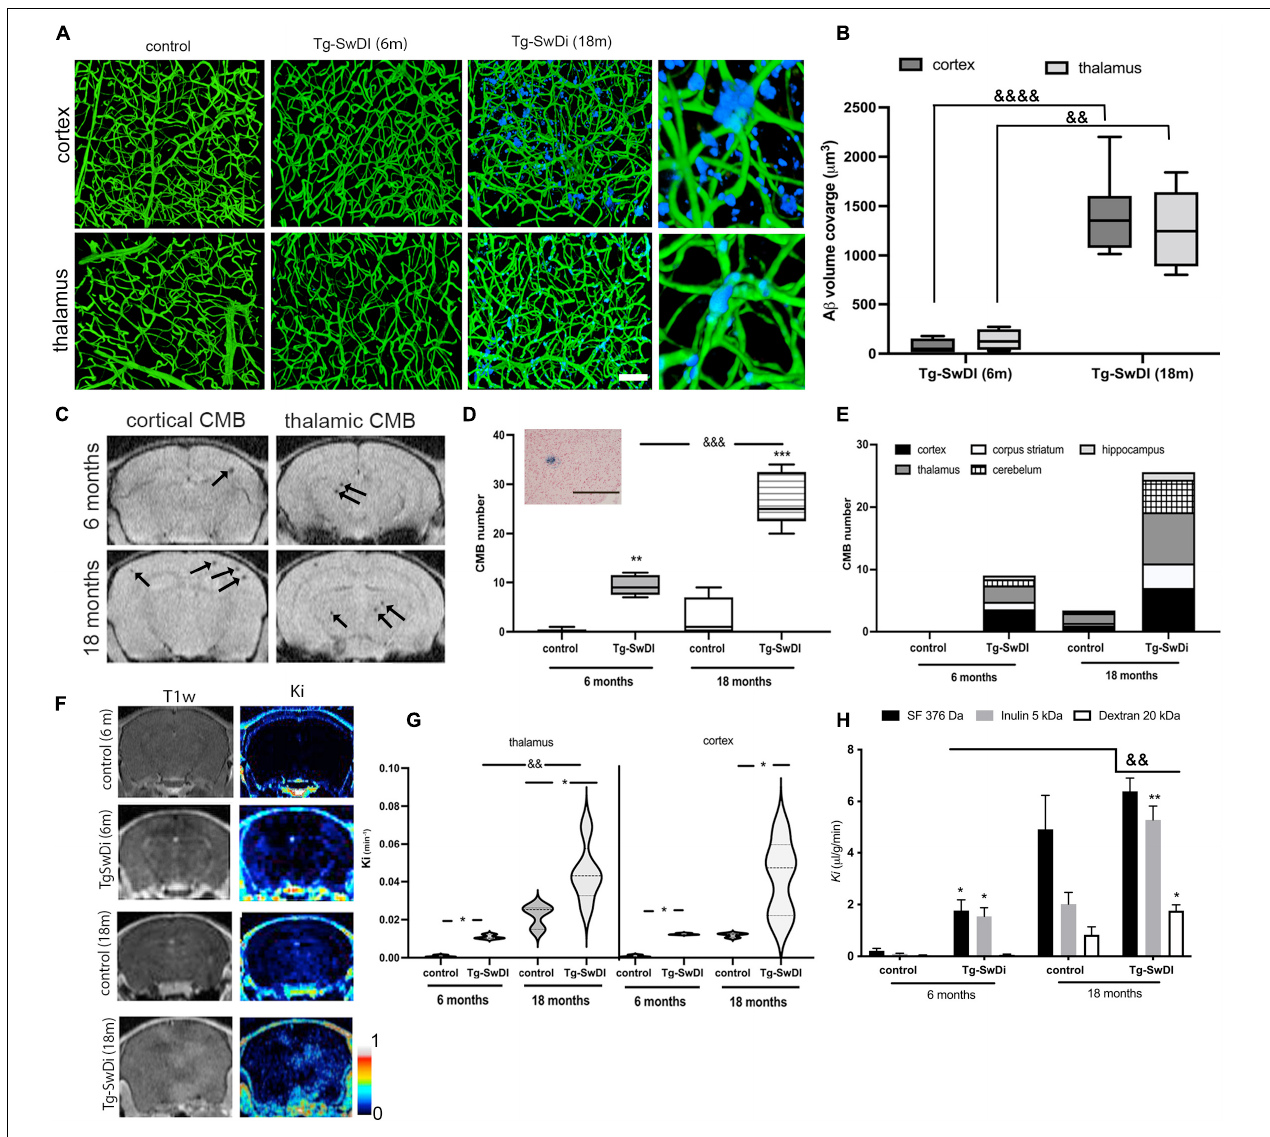
FIGURE 1 | (A) Amyloid accumulation around the brain microvasculature in cortex and thalamus of Tg-SwDi mice (6 and 18 months old) and aged wild type mice (control; 18 months old). Blood vessels were visualized by Tomato lectin Alexa488 (green) and amyloid deposition with Amyloid Glo (blue). The images represent maximal intensity projection at 250 µ m. Magnified 3-D view of the boxed region showed the localization of the A β deposit around blood vessels in the cortex and thalamus. Scale bar 100 µ m. (B) Box and whisker plot represents semi-quantitation of the blood vessel A β coverage ( µ m 3 ). Analysis of two regions (cortex and thalamus) showed a significant difference in A β deposition in Tg-SwDi mice (18 months old) in both regions compared to young Tg-SwDi mice (6 months old). No A β accumulation was present in any region in corresponding age-matched mouse brains. Values are from 15 separate slides per region in 3 mice per group && p < 0.01 and &&&& p < 0.0001 vs. young Tg-SwDI thalamus and cortex, respectively. (C) Representative T2*MRI images of cortex and thalamus of Tg-SwDI mice 6 and 18 months old. Arrows indicated the existence of small microbleeds in both regions. (D) Box and whisker plot of the total number of cerebral microbleeds (CMBs) detected on MRI in Tg-SwDI mice (6 and 18 months old) and age-matched control (WT) mice. Many CMBs were detected in Tg-SwDI mice (6 and 18 months old) with significantly more in the old Tg-SwDI group. More occasional CMBs were found in old control WT mice, but not in young WT mice. N = 10 mice per group ** p < 0.01 and *** p < 0.001 comparing age-matched mice (6 and 18 months old); &&& p < 0.001 comparing to Tg-SwDI (6 months old). Inset: Representative image for histological verification (Prussian blue staining) of a CBM (scale bar 50 µ m). (E) Stacked bars graph represents brain distribution of the CBMs in all experimental groups. ( n = 5 mice per group). (F) MRI analysis of the BBB permeability in Tg-SwDI mice (6 and 18 months old) and corresponding age matched controls. Representative of images of Gd-DTPA enhancement in T1w MRI and T1 map of blood-brain barrier transfer coefficient K i varying from 0 to 1 min − 1 . (G) Violin graphs of blood-brain barrier transfer coefficients ( K i ; min − 1 ) in thalamus and cortex, the two most affected regions, in all experimental groups. n = 10 mice per group; * p < 0.05 comparing with control; && p < 0.01 comparing young Tg-SwDi (6 months) with old Tg-SwDi (18 months). (H) Influx rate constant ( K i ) for sodium fluorescein (SF, 376 Da), Inulin (5 kDa), and dextran (20 kDa) in the whole brain in young (6 months) and old (18 months) Tg-SwDI and control (wildtype) mice. Values are means ± SD, n = 10. * p < 0.05 and ** p < 0.01 vs. corresponding aging control; && p < 0.01 vs. young Tg-SwDI.